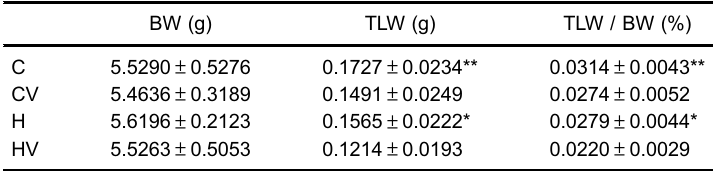
Table 1. Body weight (BW), total lung weight (TLW), and TLW / BW ratio (n=8 per